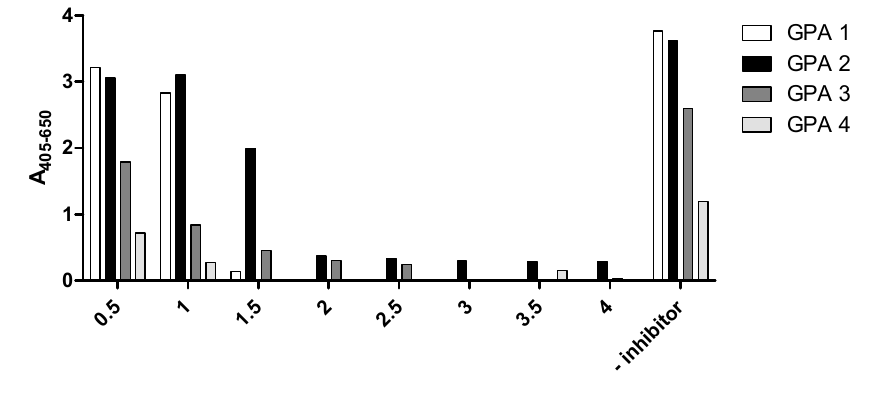
Figure 14. Effect of α 1-antitrypsin on autoantibody binding to PR3 (SSI) determined by ELISA. PR3 was pre-incubated with α -1-antitrypsin before coating in ELISA plates followed by incubation with patient sera and detection with AP-conjugated goat-anti human IgG conjugate. GPA 1 and GPA 2 were strong positive for autoantibodies to PR3, whereas GPA 3 was medium positive and GPA 4 was weak positive.